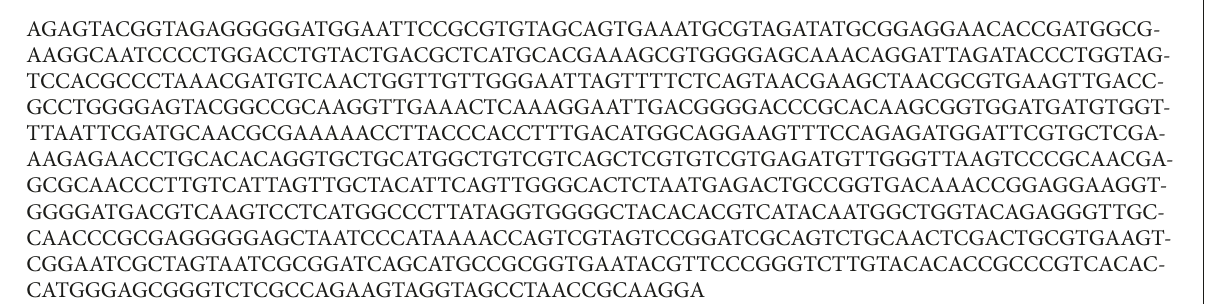
Cover of the porthole no. 13 of the service module The surface of photoelectron converters of solar panels DNA of Archaebacteria Radiator surface of the thermoregulation system of the service module Radiator surface of the thermoregulation system of the service module, between radiator tubes